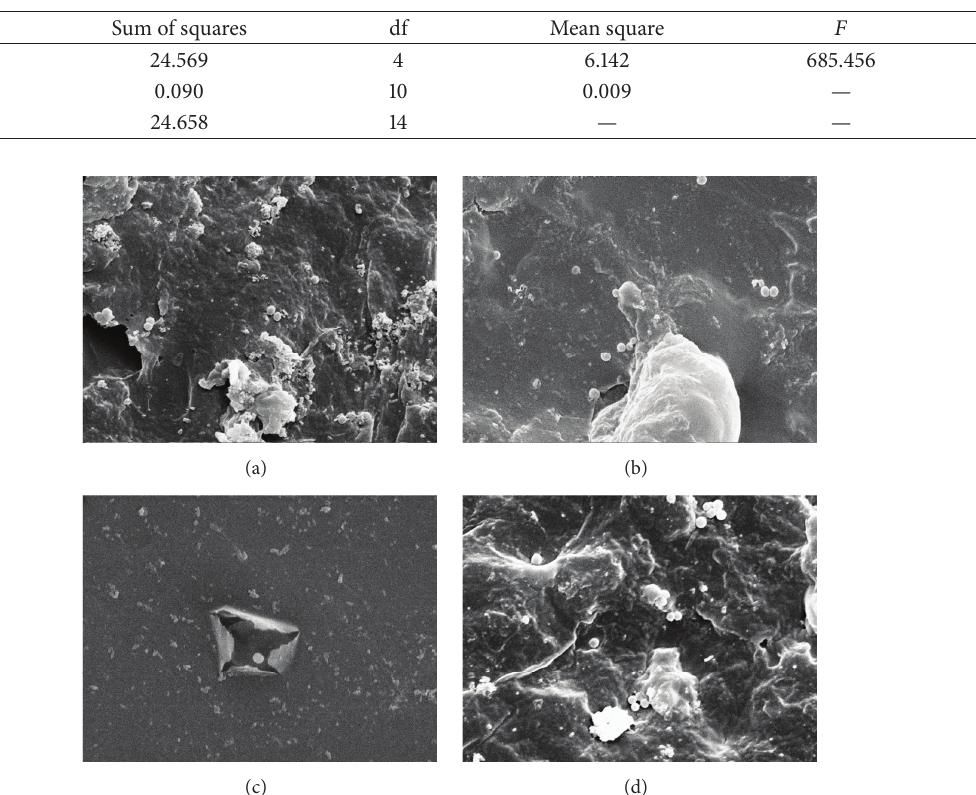
Table 2: One-way ANOVA analysis of surface roughness.